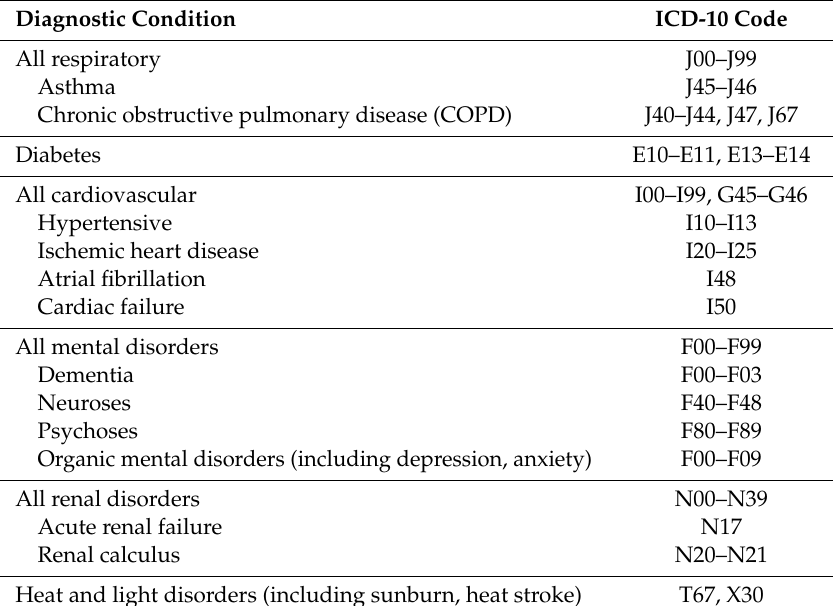
Table 1. International Classification of Disease (ICD-10) codes for analyzed diagnostic